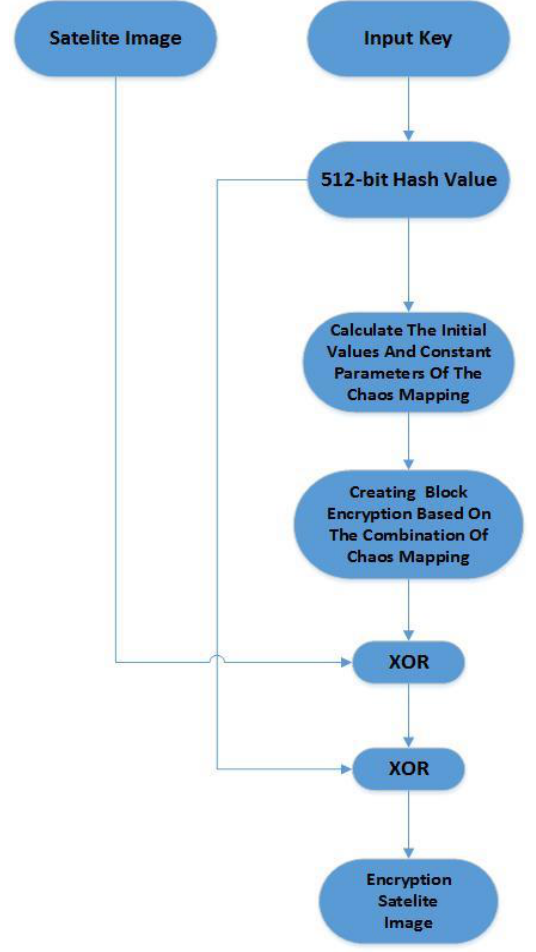
Figure 6. Block diagram of encryption process.